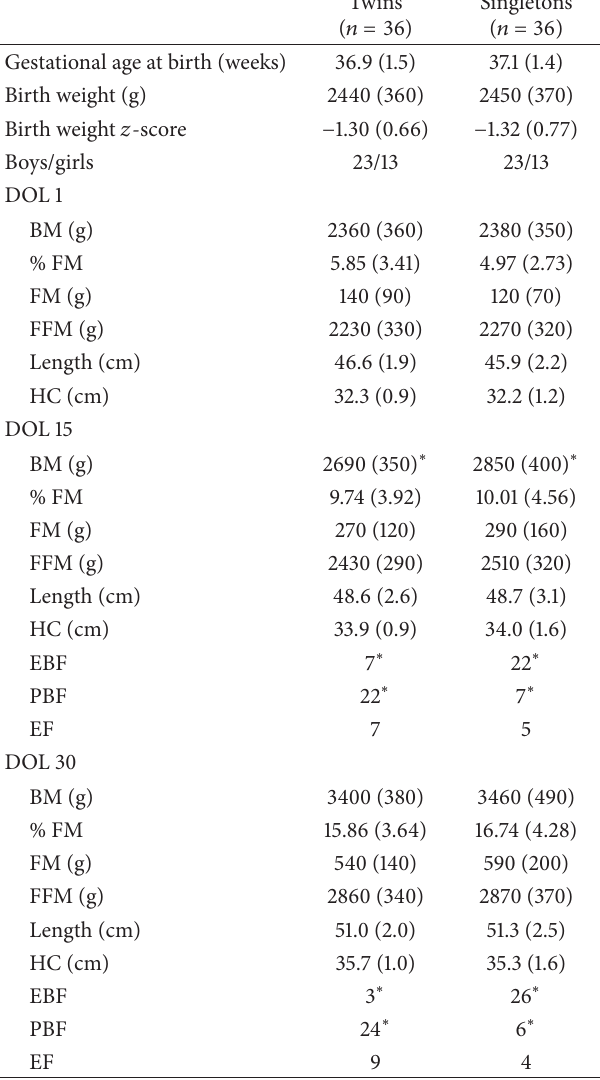
Table 1: Growth and body composition of twins versus matched